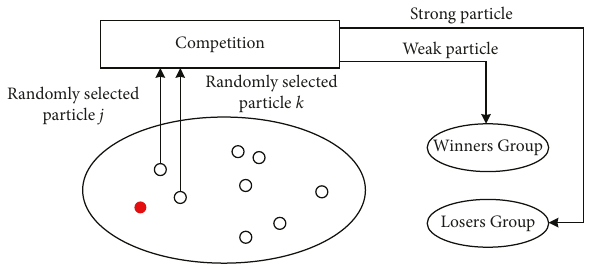
Figure 1: The competition